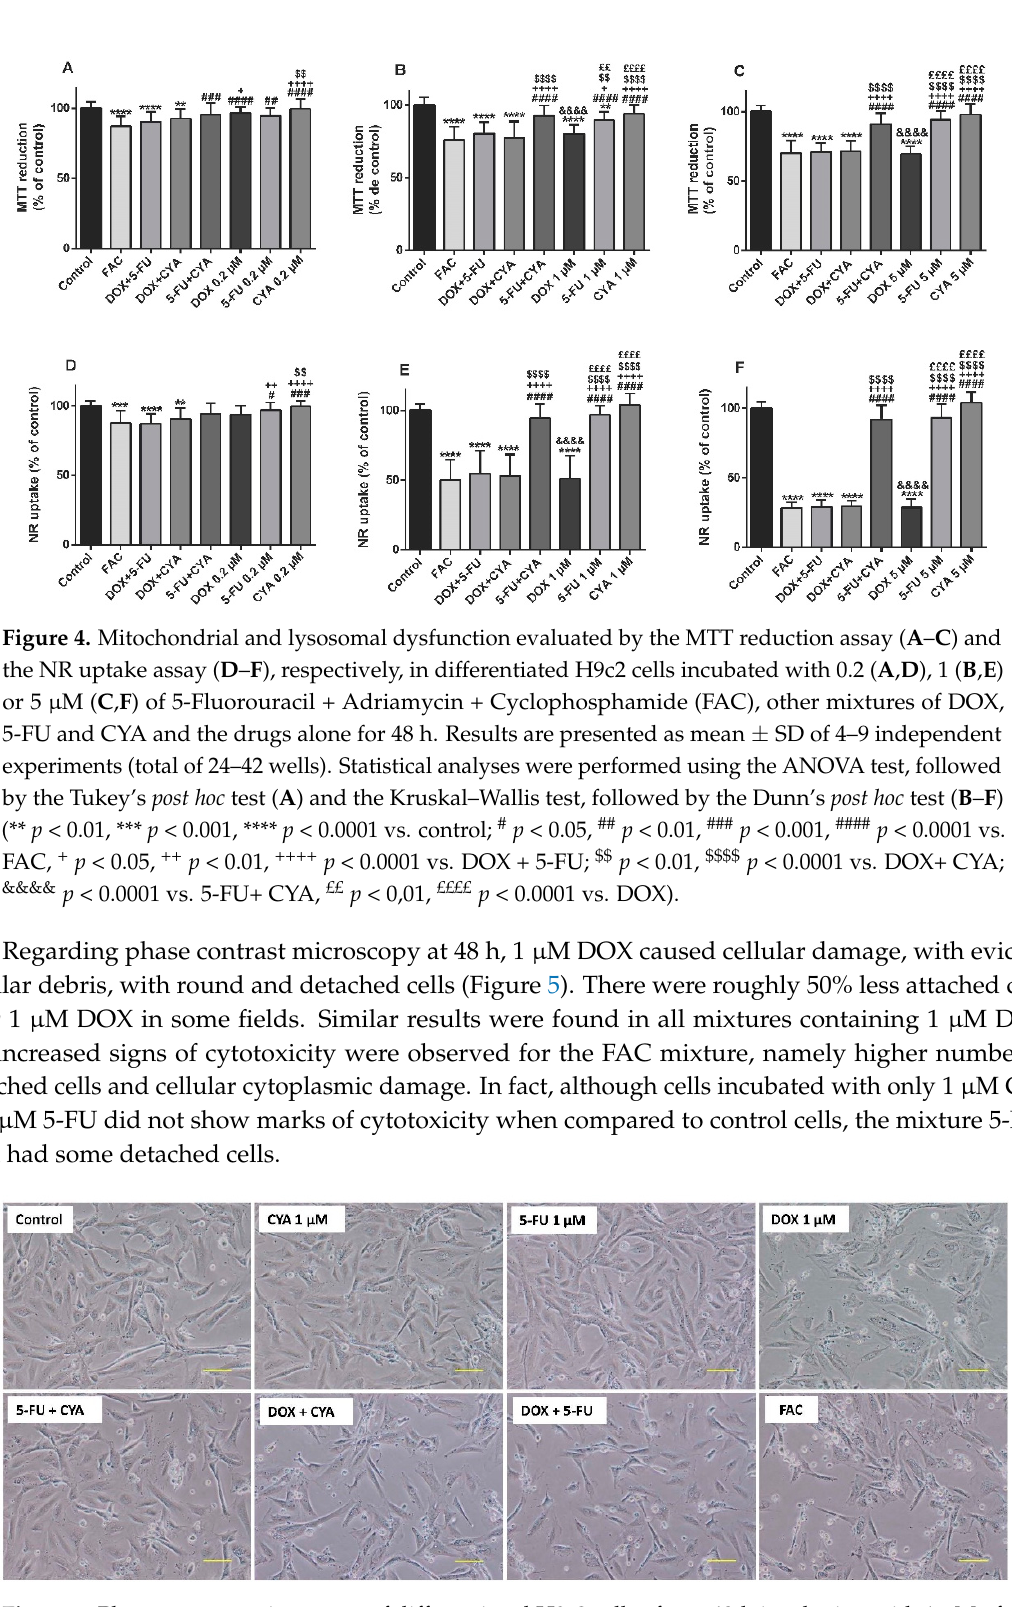
Figure 5. Phase contrast microscopy of differentiated H9c2 cells after a 48-h incubation with 1 μ M of FAC, other mixtures of DOX, 5-FU and CYA and the drugs alone. Images are representative of two independent experiments (scale bar 100 μ m).